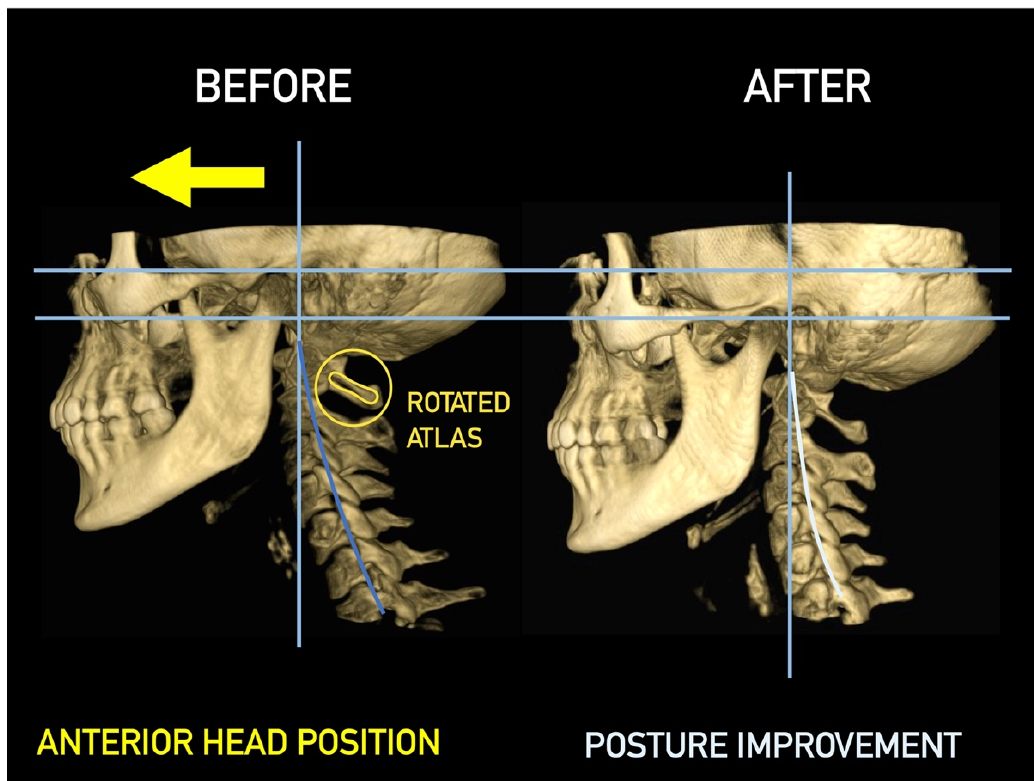
Figure 28. Effect of cervical vertebrae alignment. Lateral view.